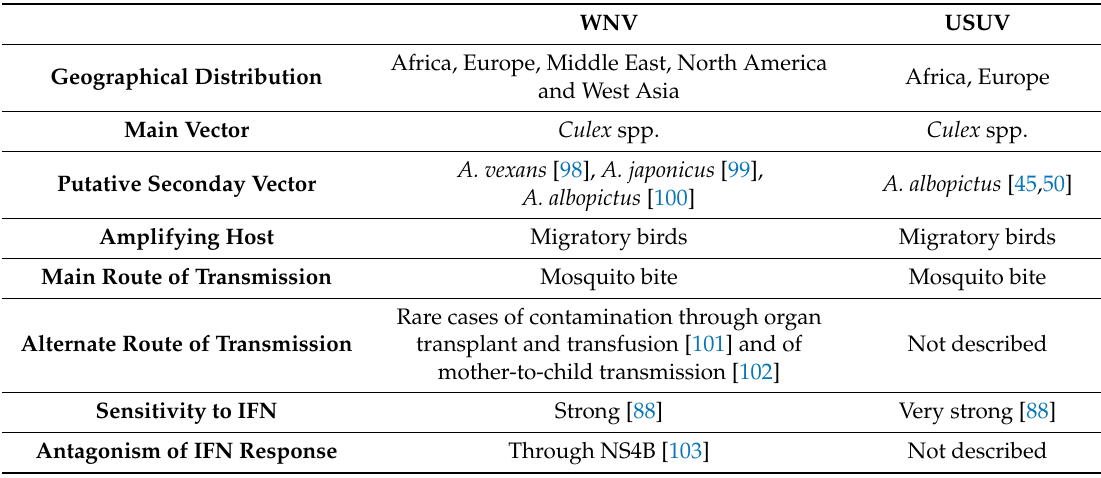
Table 1. Comparison of WNV and USUV main characteristics. Some important features of West Nile Virus (WNV) and Usutu Virus (USUV) are listed here, with the corresponding bibliographical references.